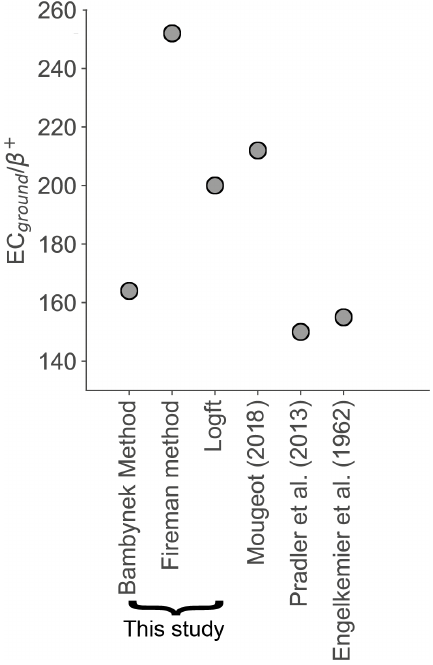
Figure 2. Comparison of theoretically calculated EC ground /β + of 40 K in this study using three methods: (1) Bambynek method (Bambynek et al., 1977), (2) Fireman method (Fireman, 1949), and (3) LogFT (ENSDF collaboration, 2020, LogFT). The value of Chen (2017) is not included in the figure as it is an extreme out- lier, and the authors do not explain the method they use to reach this value. Our calculated ratios are compared to previous evalua- tions in the literature (Engelkemeir et al., 1962; Pradler et al., 2013; Mougeot, 2018). Uncertainties in these values are either intractable or, in the case of Mougeot (2018), too small to plot. Note the consis- tency in the estimated ratio from all of the methods. Uncertainties are unknown in all cases except Mougeot (2018), where the uncer- tainty is too small to